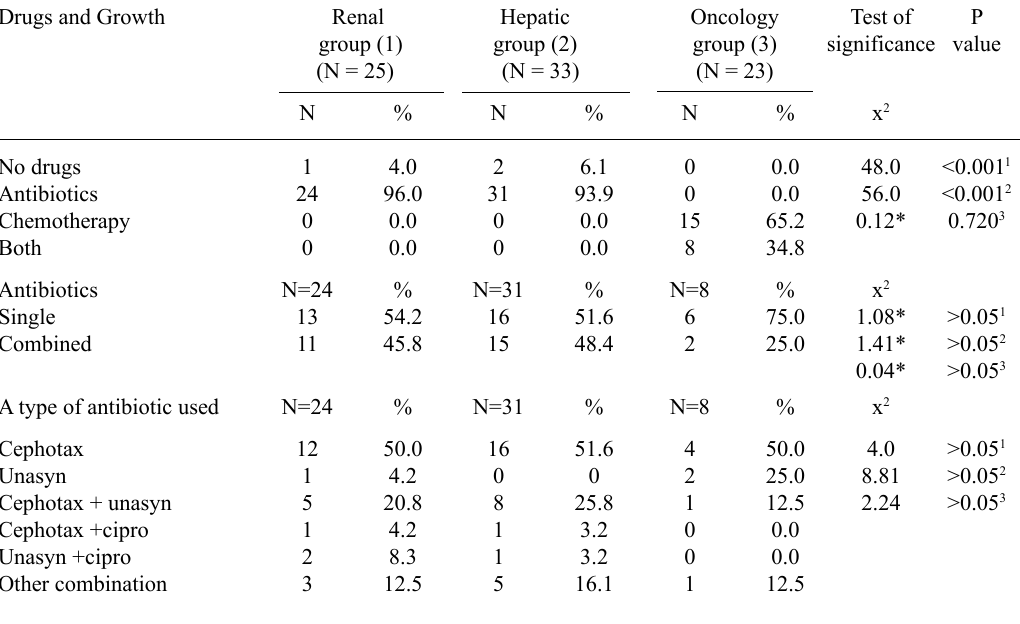
table 6. Drugs used in patients of study groups with bacteria